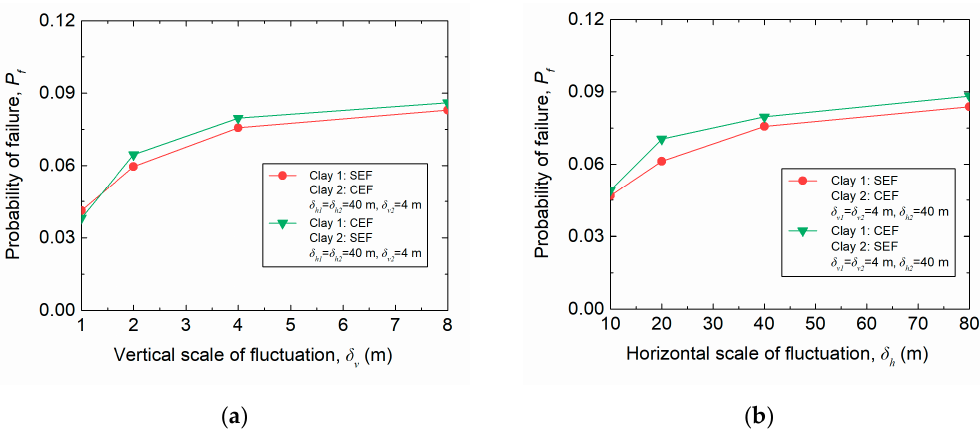
Figure 8. Influence of SOFs in the lower stratum on slope failure probability: ( a ) Slope failure probability versus δ v 1 ; ( b ) Slope failure probability versus δ v 1 .